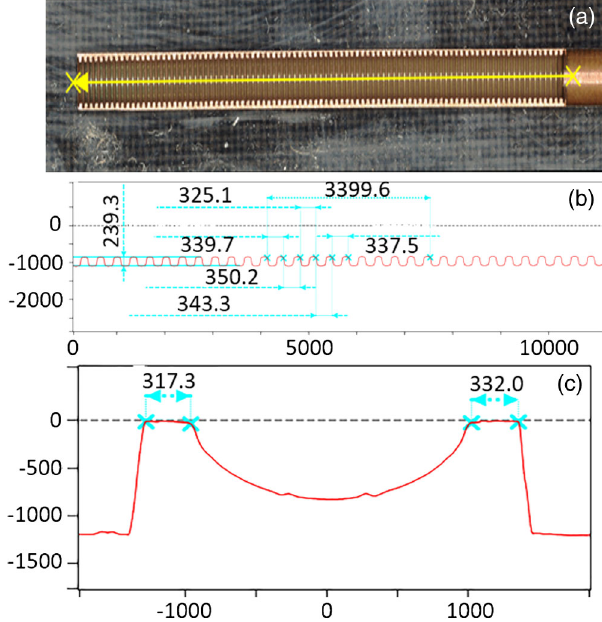
FIG. 6. (a) A fragment of the CWG with one half open. (b) Longitudinal profile of the corrugations measured along the line at the bottomofthe CWG.(c)Cross-sectional profilemeasured in the middle of the tooth. All dimensions are in